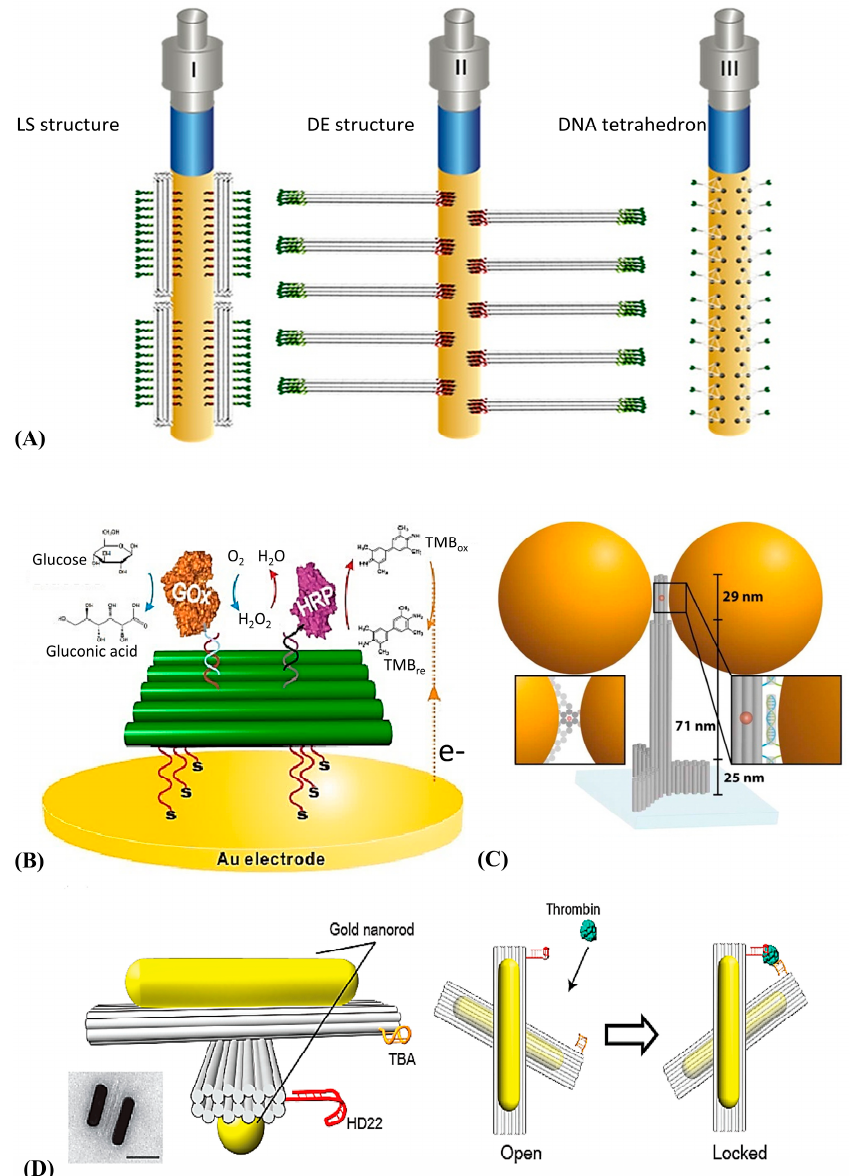
Figure 8. ( A ) The DNA origami LS (left), DE (middle), and DNA tetrahedrons (right) as the anchoring point of the thrombin-specific aptamers on the SPR biosensor. Reprinted (adapted) with permission from [160]. Copyright (2018) American Chemical Society. ( B ) The enzyme-catalyzed reactions are controlled by adjusting the distance between the GOx and HRP. Reprinted (adapted) with permission from [163]. Copyright (2019) American Chemical Society. ( C ) The DNA origami pillar was constructed to build the optical nanoantenna with two 100 nm Au nanoparticles together. Reprinted (adapted) with permission from [177]. Copyright (2021) American Chemical Society. ( D ) The schematic diagram of the reconfigurable 3D plasmonic metamolecules [182]. Copyright (2019) MDPI, Basel, Switzerland, under the Creative Commons Attribution License.